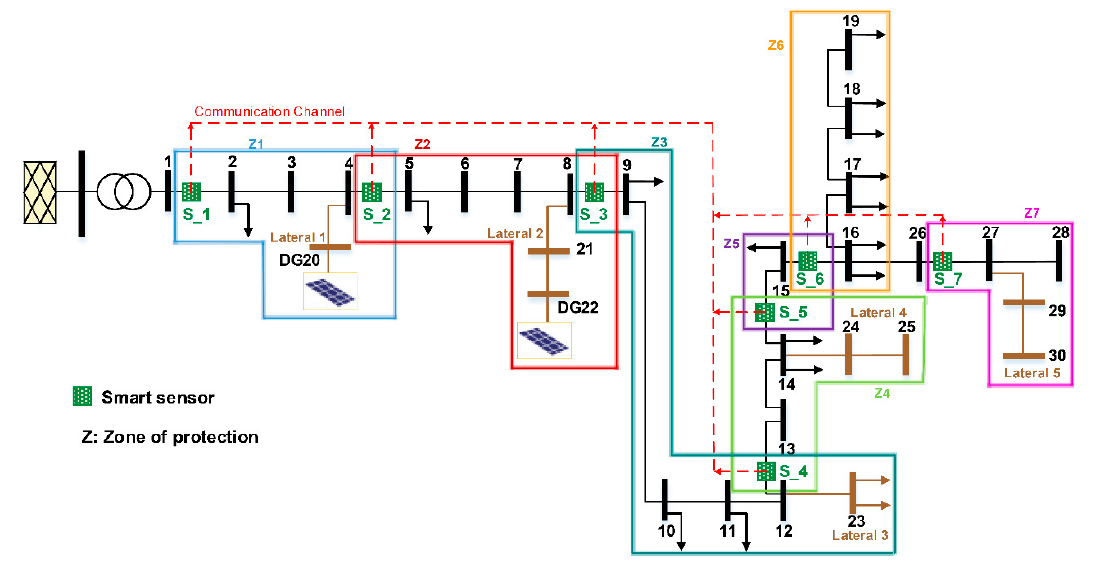
Figure 7. Modified IEEE 34-Node Test Figure 7 . Modified IEEE 34-Node Test Feeder.